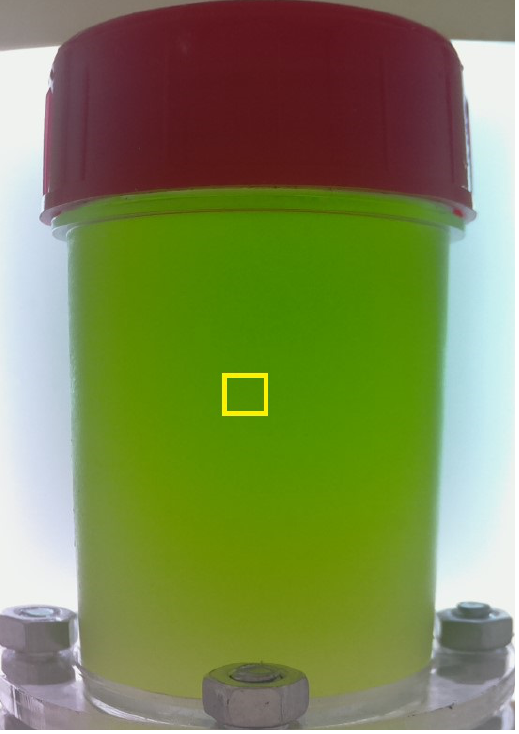
Figure 3. A raw image of microalgae captured by our developed